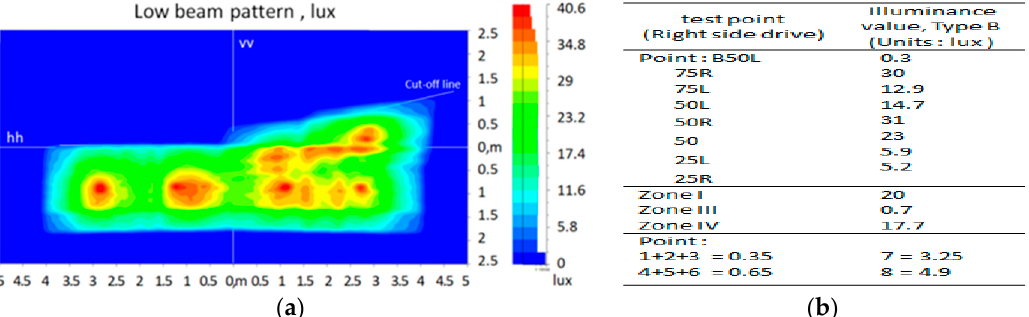
Figure 9. ( a , b ) Simulation results of low-beam pattern and experimental results.